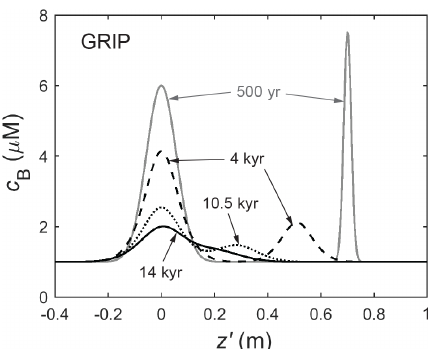
Figure 10. Snapshots (at four times) of the evolution of two neigh- bouring peaks in a GRIP run that uses the control parameters of the run in Fig. 5a. Diffusional spreading causes the peaks to merge as they approach each other under vertical compression. See Movie S3 for the full